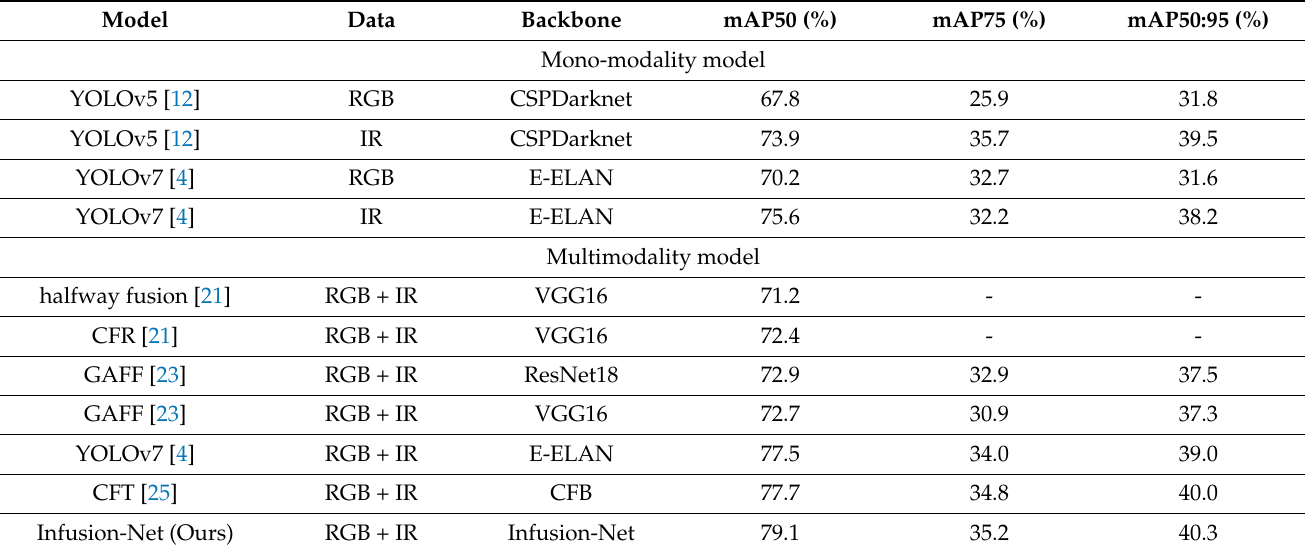
Table 1. Comparison of the Infusion-Net and other models on the FLIR dataset